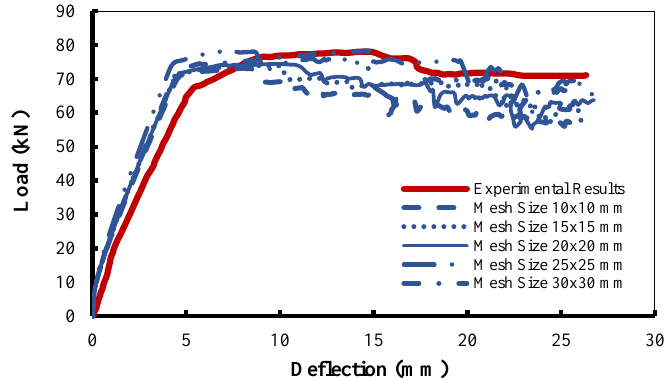
Figure 8. Sample of Mesh Sensitivity Analysis (Murthy et al. [47]).